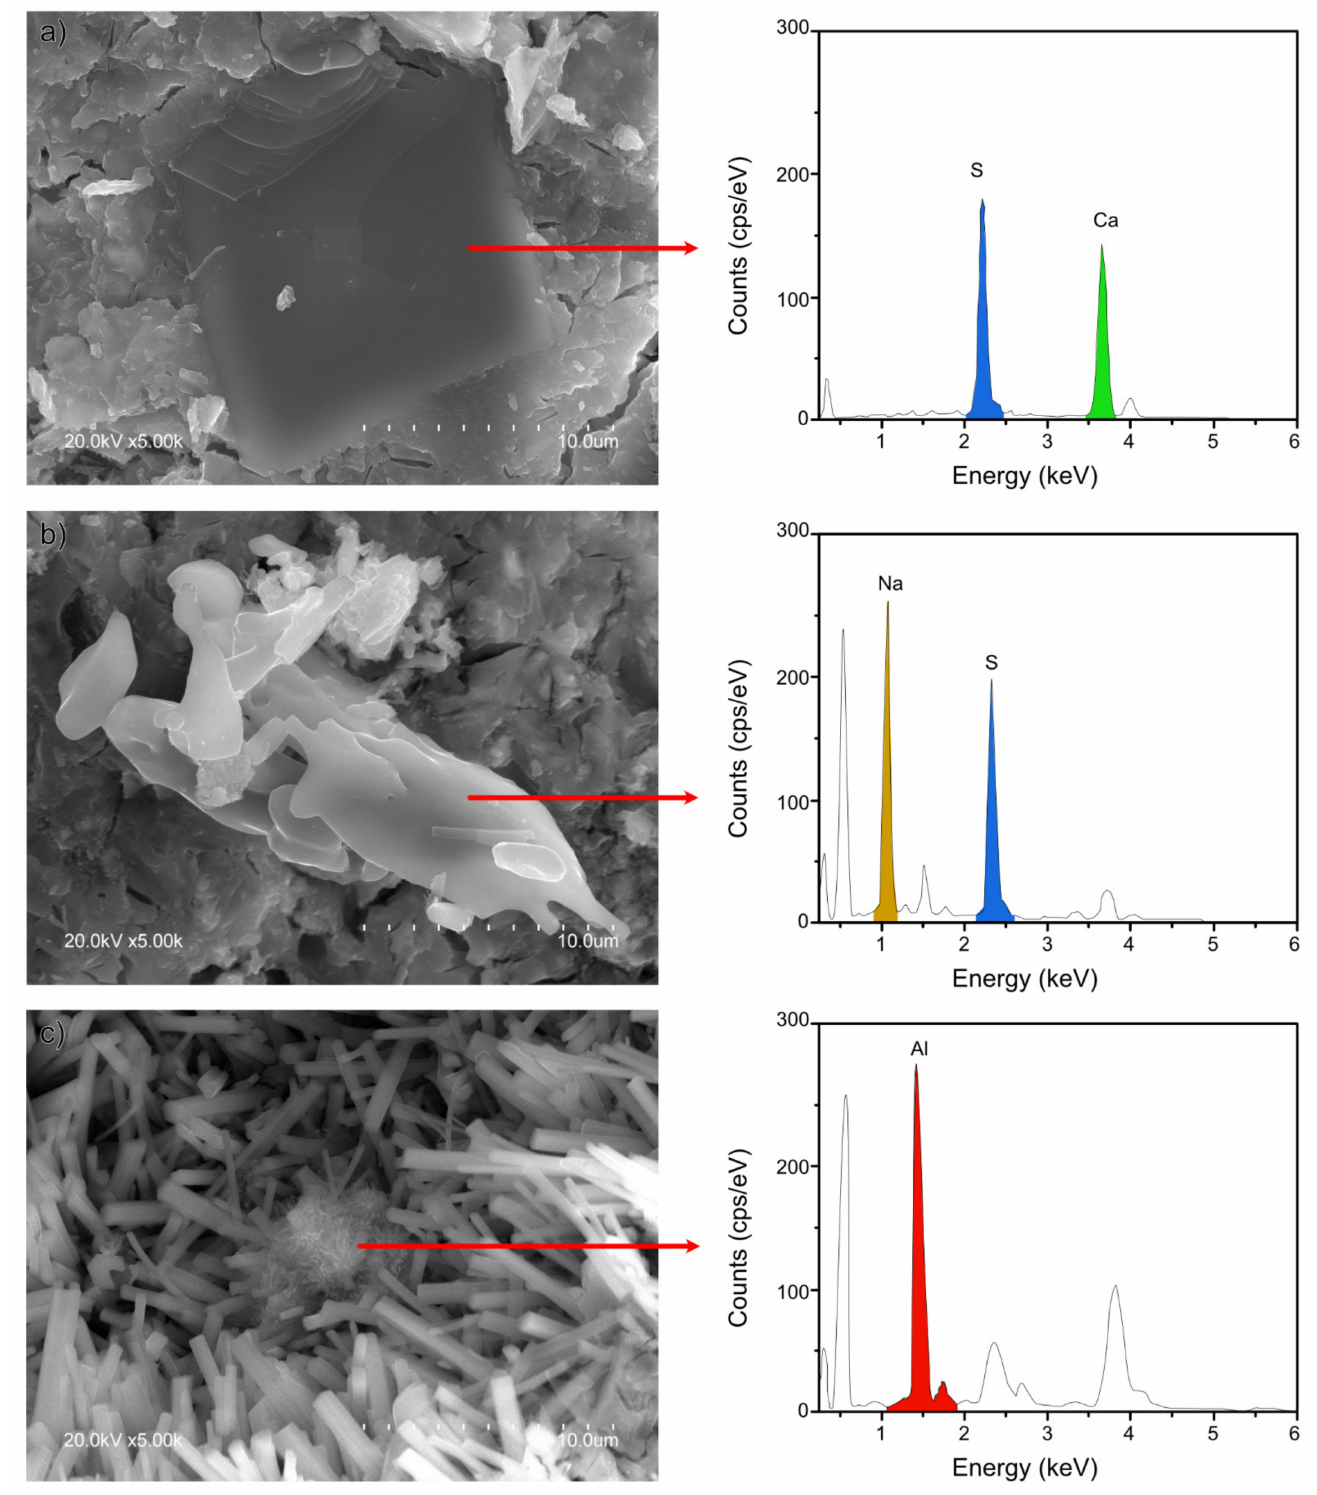
Figure 7. SEM micrographs (at 5000 × ) of sample 5NS showing: ( a ) gypsum; ( b ) thenardite; and ( c ) AH 3 . The size of the ettringite crystals in sample 5NSi was similar to the dimensions observed for REF. No strätlingite-like particles (identified only after 90 d by XRD and FTIR) were detected on the 28-d micrographs, inasmuch as that mineral forms more slowly [35]. EDS analysis of the amorphous matrix revealed the presence of silicon (see Figure 6D.2), a Ca/Si ratio of 0.15 to 0.35 and an Al/Ca ratio of around 1, the theoretical value.